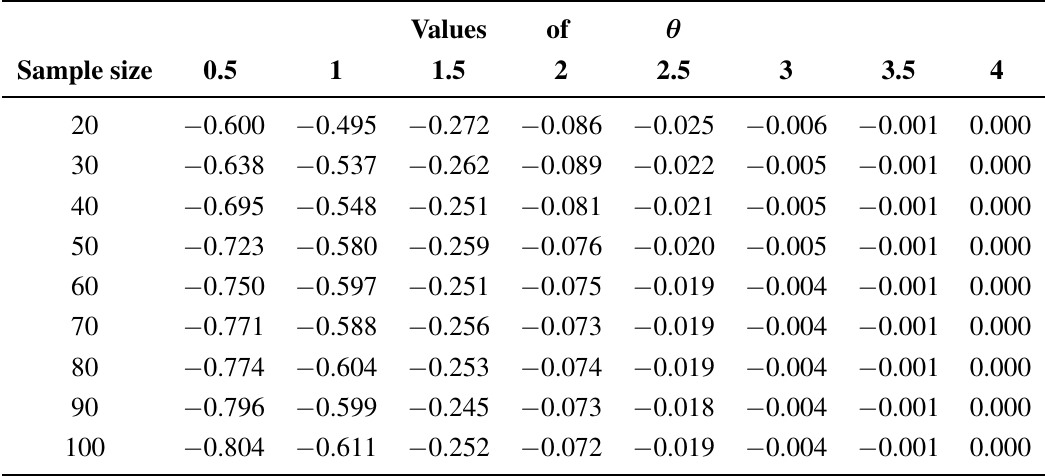
Table 5. Estimated correlations between the two parameters obtained from the observed information matrix.